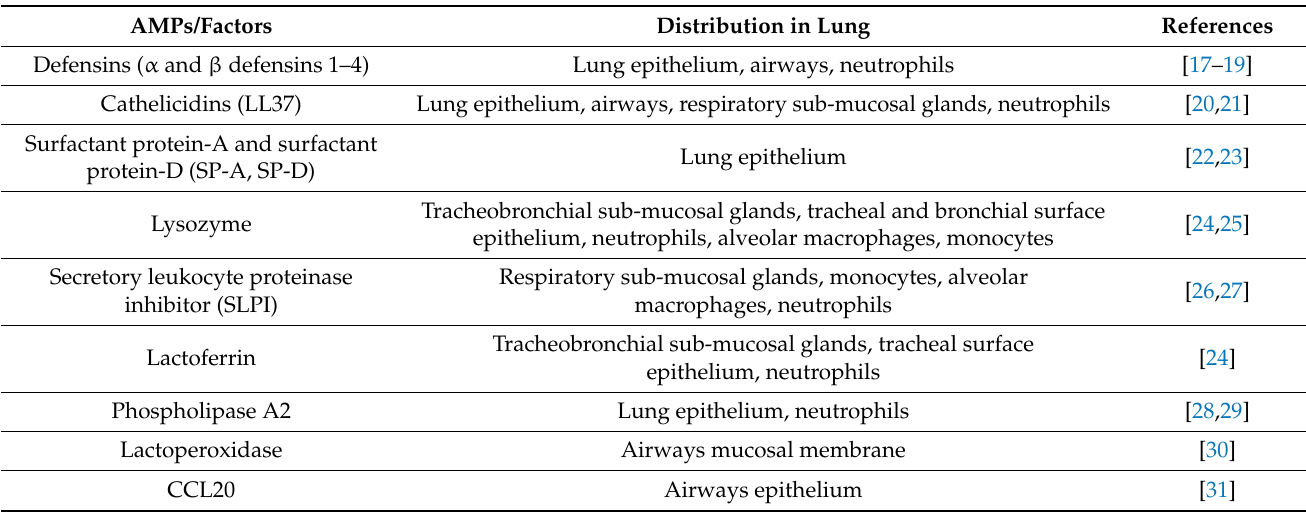
Table 1. Major AMPs/factors produced in the lung and respiratory